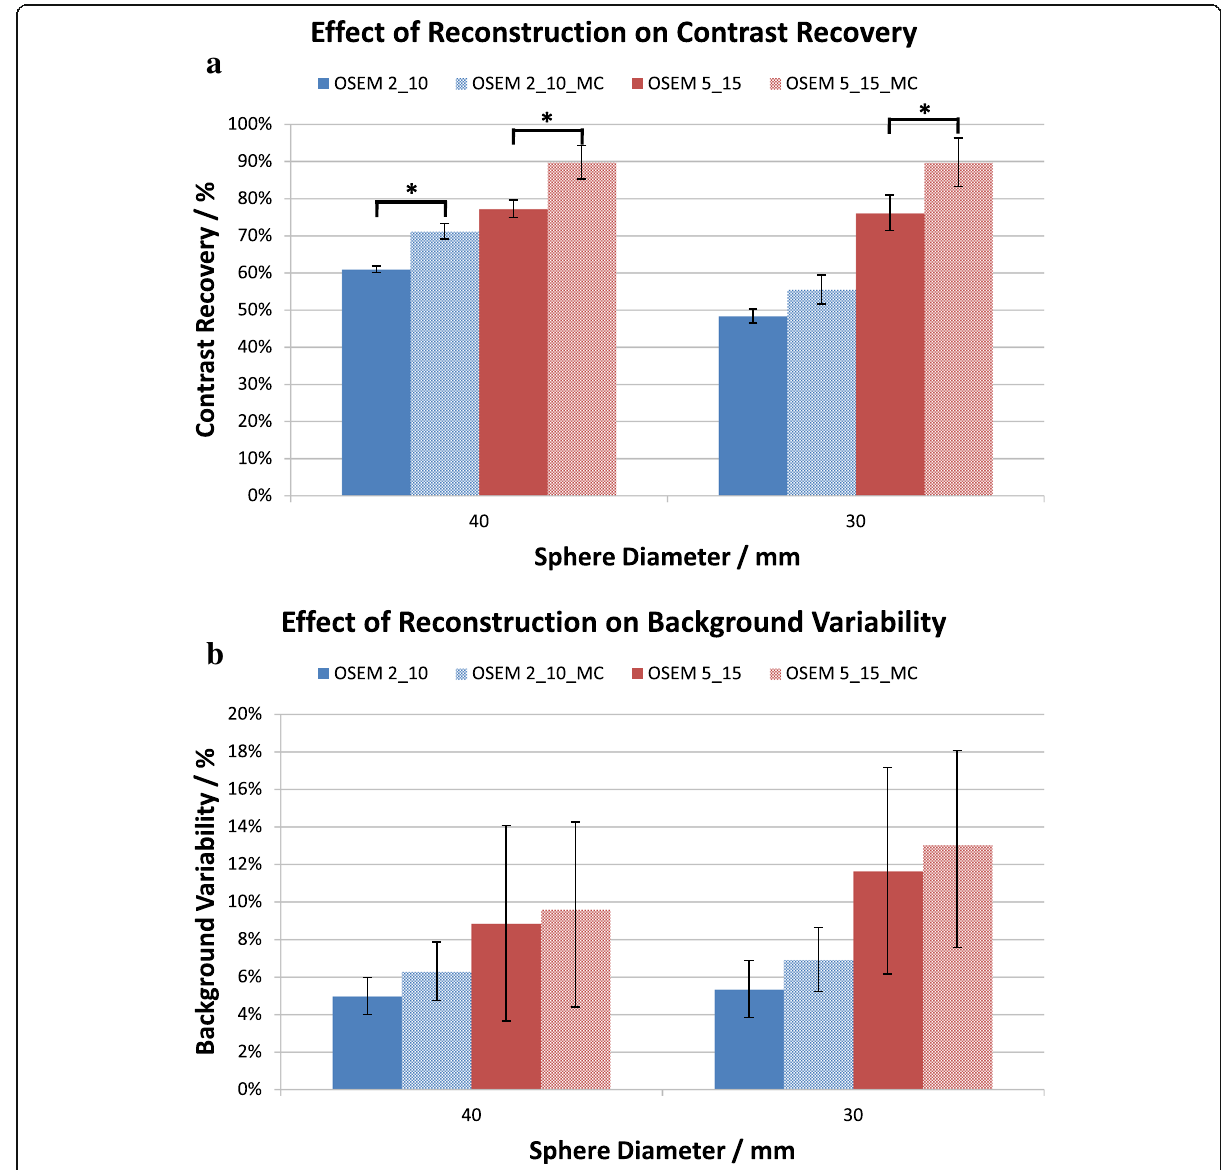
Fig. 3 Effect of full Monte Carlo collimator modelling on a contrast recovery ( p values left to right = 0.041, 0.048, 0.086, 0.040) and b background variability for the 40- and 30-mm sphere sizes. Error bars indicate the standard error